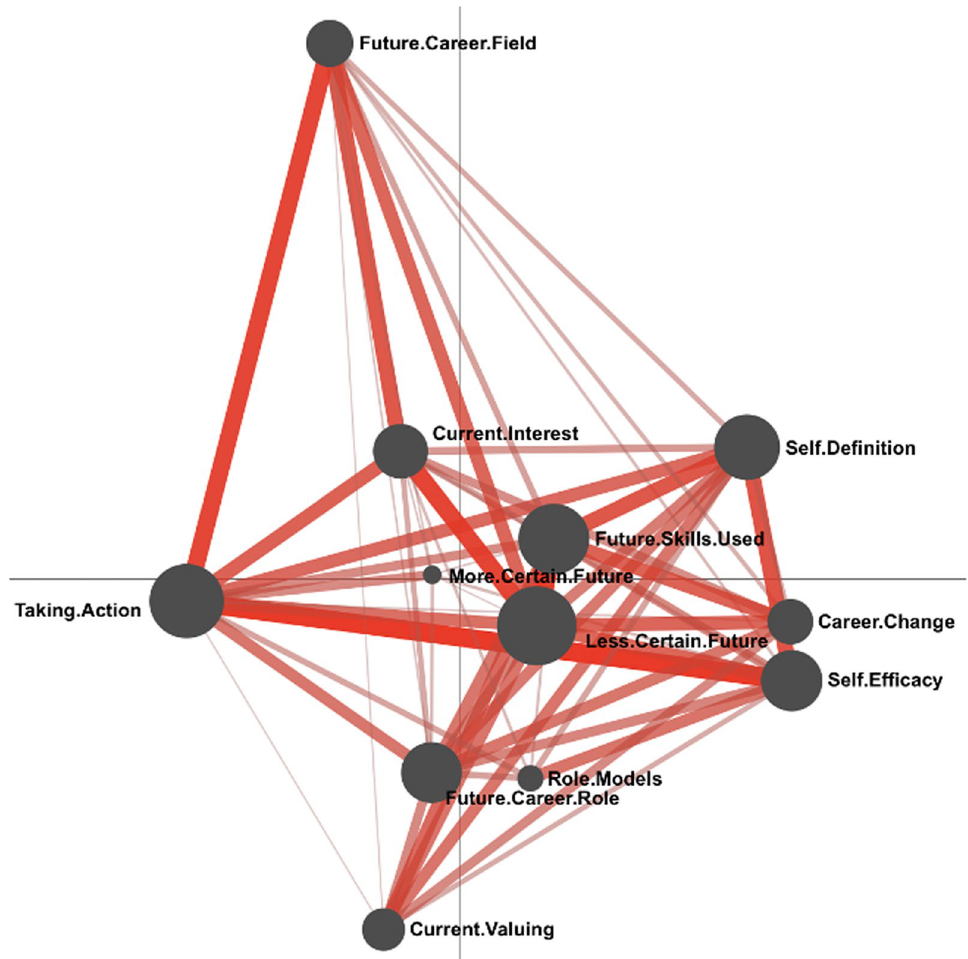
Fig. 3 Epistemic network of associations between identity themes for alumni